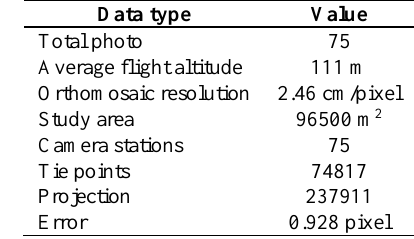
Table 2. Block adjustment